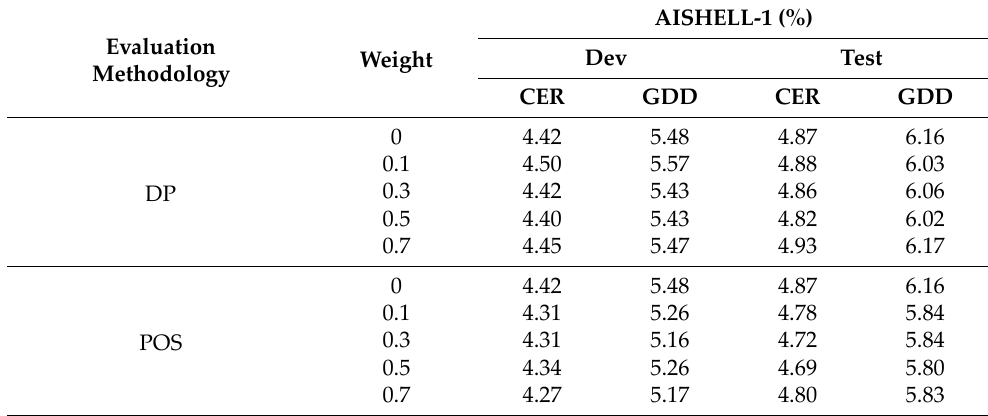
Table 4. The ablation experiments of